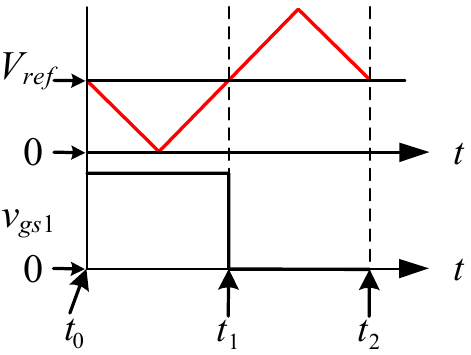
Figure 4. Gate driving signal for S 1 . Interval [ t 0 ≤ t ≤ t 1 ] : The switch S 1 is on, but the switches S 3 and S 10 are off.